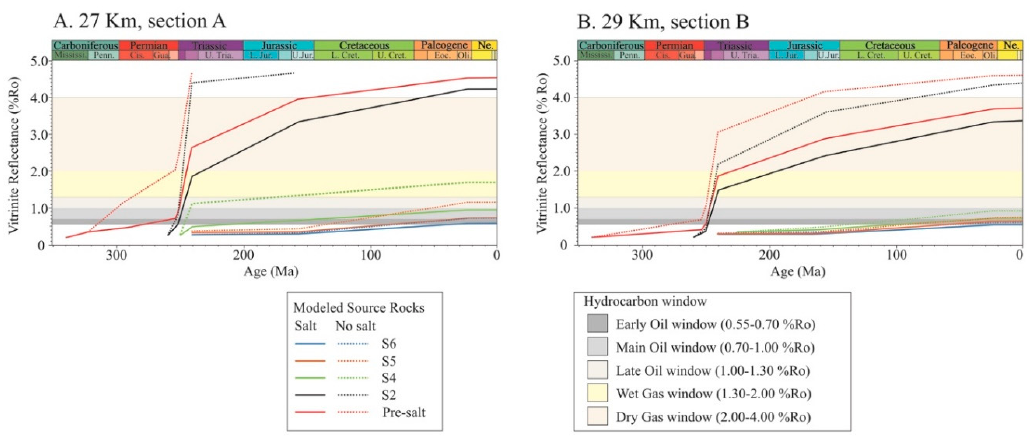
Figure 10. Source rock maturation through time in a pseudo-well perforating a minibasin in ( A ) section A in the central sub-basin, and ( B ) section B in the eastern sub-basin. Two scenarios are compared: One with salt structures as observed today (continuous lines), and another without salt structures (dashed lines). Figure 9 (I) shows the location of the pseudo-wells.